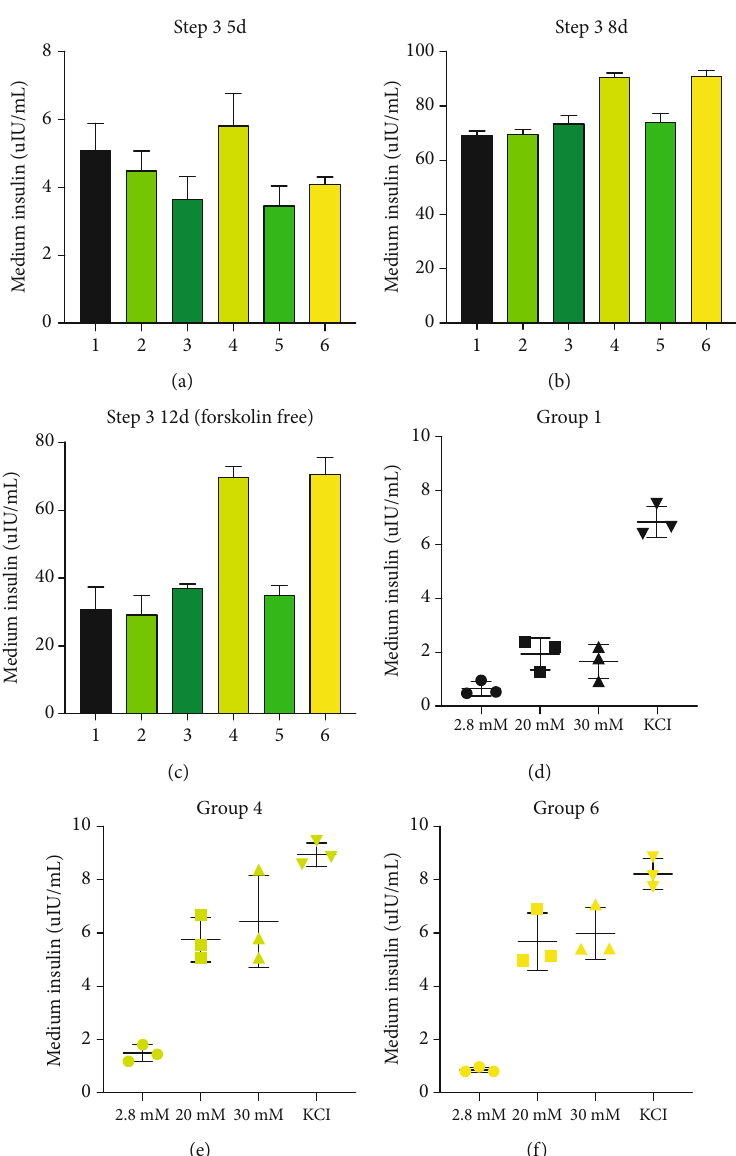
Figure 5: Functional abilities of di ff erentiated IPCs. (a) Insulin detected in culture media of all groups on day 5 of di ff erentiation step 3. Insulin levels are higher in group 4 incubated with SANT-1 than in other groups ( n = 3 ). (b) Insulin secretion is signi fi cantly increased in all groups on day 8 of step 3, especially in groups 4 and 6, where values exceeded the measurement range ( n = 3 ). (c) In general, insulin concentrations in culture medium without forskolin are low, except in groups 4 and 6 ( n = 3 ). (d) The insulin expression is not signi fi cantly a ff ected by glucose concentration in cells incubated with only the basic di ff erentiation factor at di ff erentiation step 2. (e) Insulin secretion is increased in response to 20 and 30 mM glucose in group 4, which was incubated with SANT-1. (f) di ff erentiated cells in group 4 respond to high glucose concentrations by increasing insulin secretion, like group